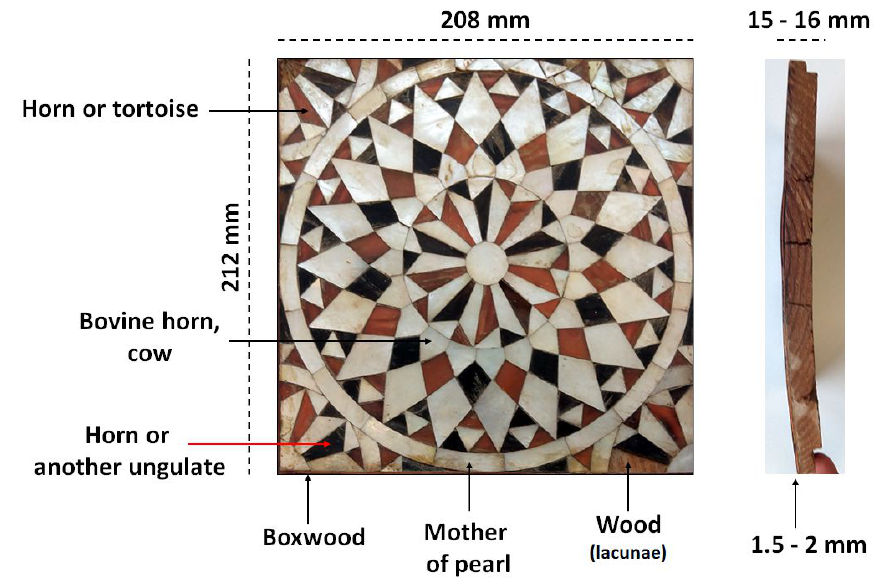
Figure 1. The marquetry sample: top (on the left ) and cross section (on the right